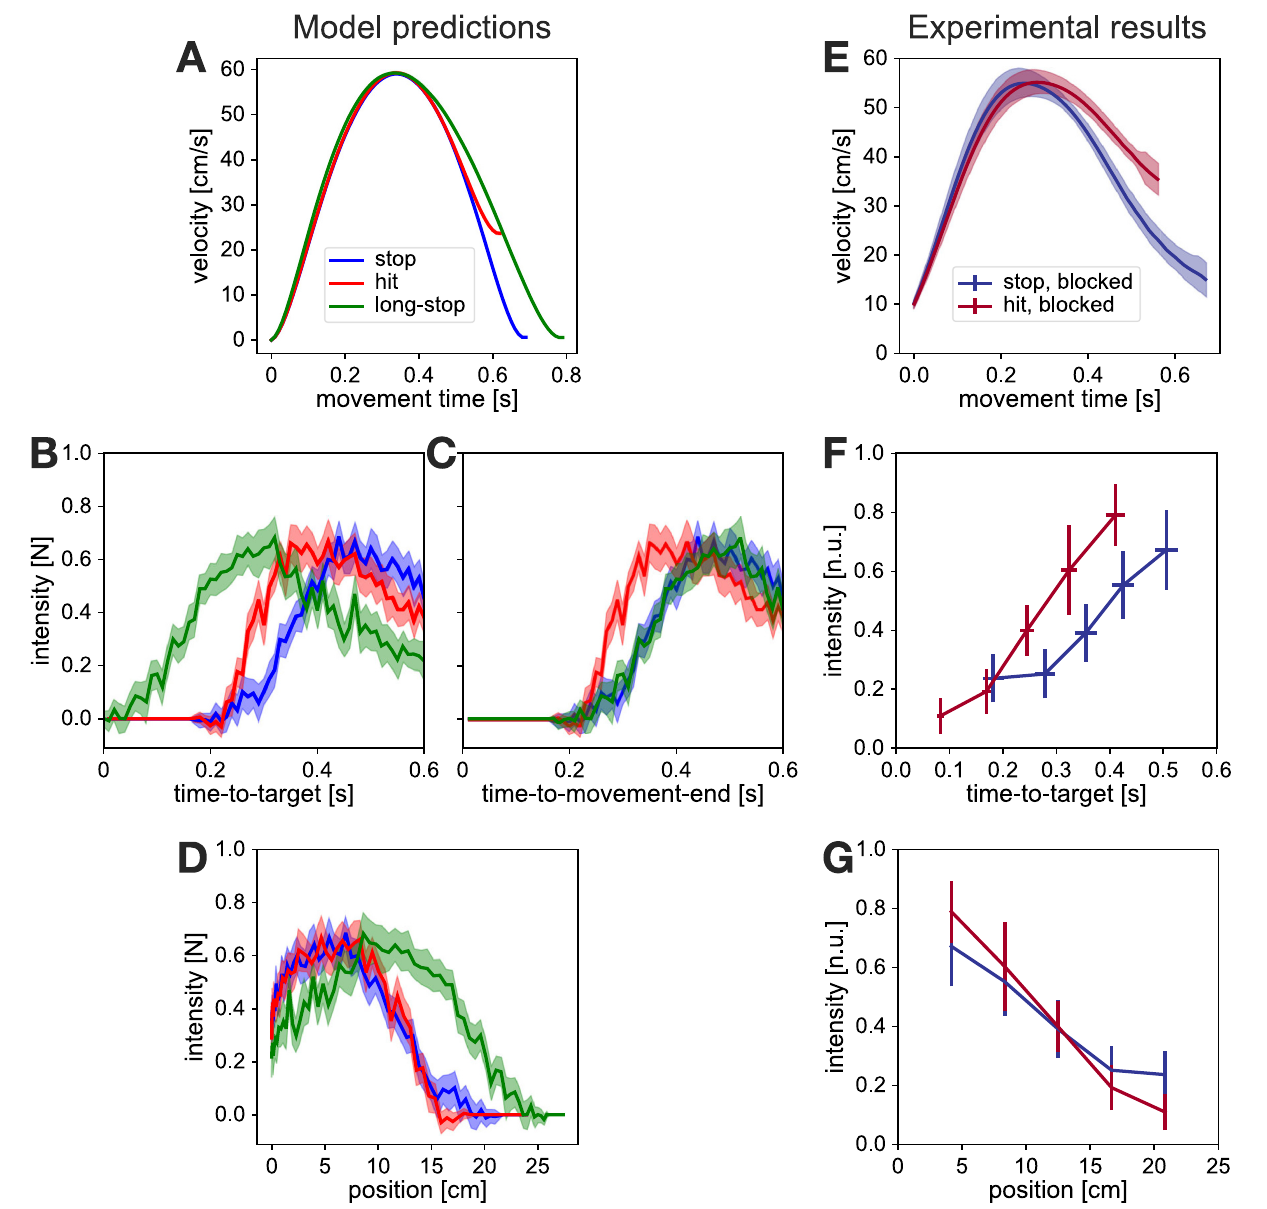
Fig 3. Comparison of OFC model predictions and experimental results. A . Simulated kinematics of stop, hit and long-stop conditions. Stop and hit conditions produce matching kinematics that only deviate shortly before movement end. The long-stop condition is a control simulation, that matched the kinematics of the hit condition for the duration of the hit movement, but was achieved with the same stop controller. B . Simulated feedback intensities as a function of time-to-target and C . time-to-movement-end. Simulations predict a faster increase of response intensities for hit condition than for stop condition. As the long-stop condition is simulated via a longer (28 cm) movement, the time-to-target represents a time until the simulated movement crosses a point of 25 cm distance (the target distance). For hit and stop conditions, time-to-target and time-to-movement-end are identical. When expressed against time-to-movement-end, long-stop produces matching responses to the stop condition, as the feedback controller used for these movements is identical. With respect to the time-to-target, long-stop responses are time-shifted from the stop responses. D . Simulated feedback intensities as a function of the position. Stop and hit simulations with these particular kinematics produce matching feedback intensity profiles when expressed against position, even if the feedback controllers are different. In contrast, the long-stop simulation with a feedback controller matching that of the stop condition still produces different intensity profile against position. Shaded areas in simulated traces represent 95% confidence intervals for simulated results. E . Velocity profiles of participants in blocked stop and blocked hit conditions. The profiles match the task requirements. F . Normalised feedback intensity profiles of participants in blocked stop and blocked hit conditions, expressed against time-to-target. Participants produce stronger responses at matching time-to-target in the hit condition, consistent with simulation results for hit and stop. G . Normalised feedback intensity profiles of participants in blocked stop and blocked hit conditions, expressed against position. Participants produce matching responses within hit and stop conditions, supporting model simulations for stop and hit conditions, and not stop and long-stop. Error bars in experimental results represent 95% confidence